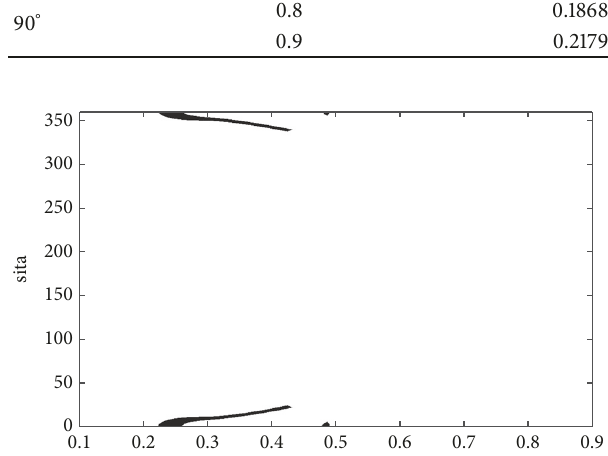
Figure 11: Initial phase and eccentricity values corresponding to temporarily nonpositive Kepler energy in the 1:2 resonant family.